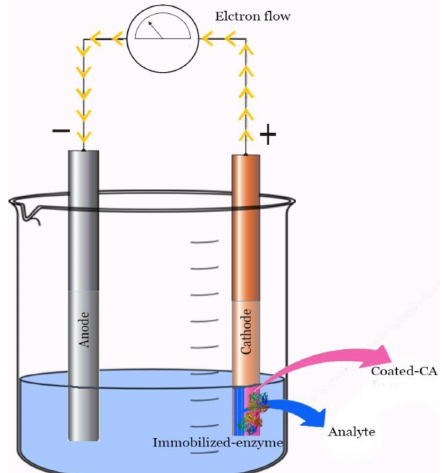
Fig. 2 . Schematic view of an amperometric determination of analyte based on immobilized CA on the